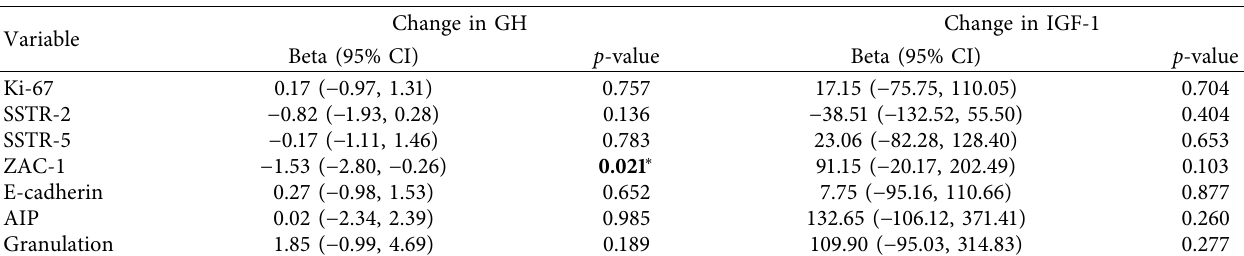
Table 2: Linear regression for predicting change in GH (delta GH) [first two panels], and IGF-1 (delta IGF-1) [last 2 panels], before and after treatment with SS-a based on histological markers, corrected for baseline GH and IGF-1 values